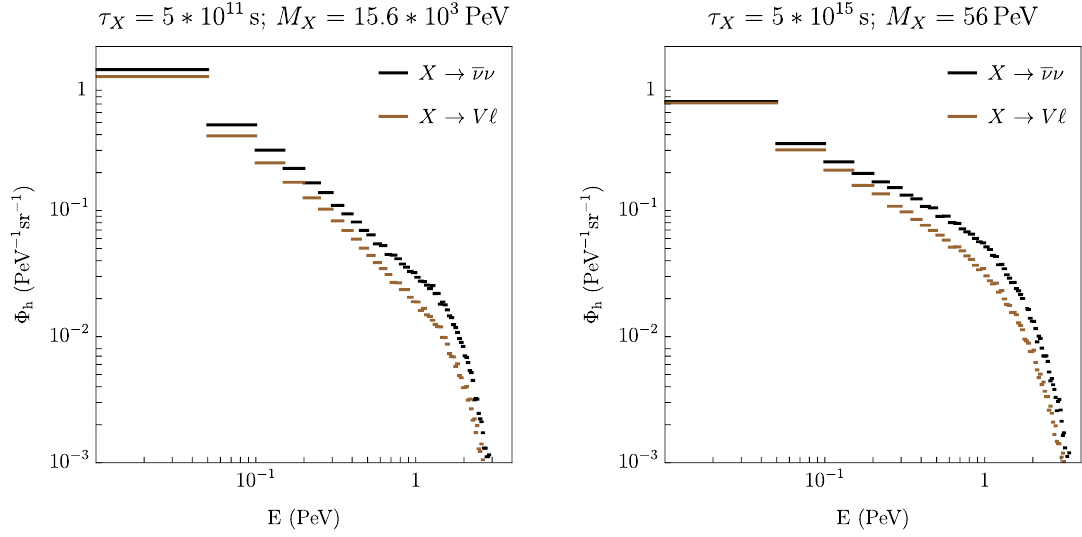
Figure 1 . (cid:8) h ( t 0 ; E ) for a heavy decaying relic X for two di(cid:11)erent lifetimes and two di(cid:11)erent decay models. The mass of X is set to M X = 2 : 4 (1 + z (cid:28) spectrum measured at IceCube in the energy range 0 : 25{4 PeV [4]. z (cid:28) decay lifetime (cid:28) X